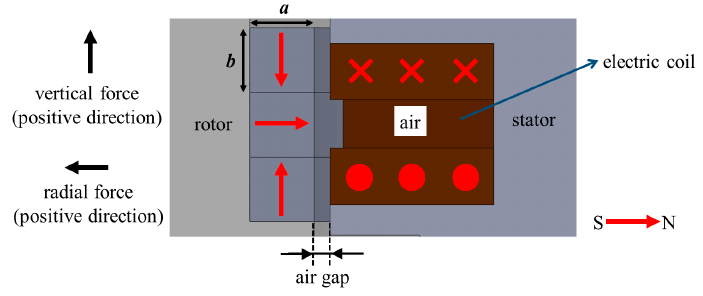
Figure 2. The schematic of the radial hybrid magnetic bearing (HMB).